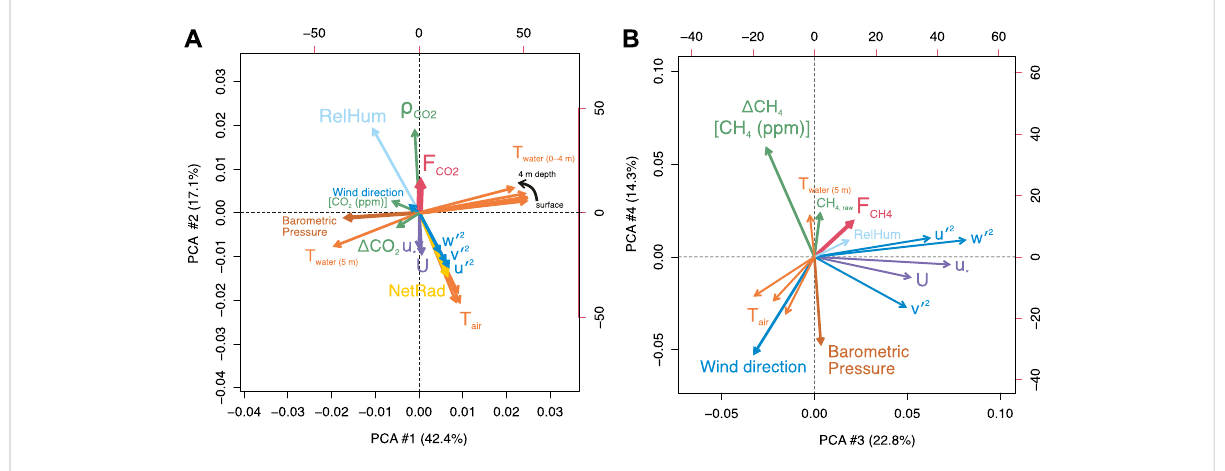
FIGURE 4 Principal component biplots of (A) CO 2 fl ux and (B) CH 4 fl ux with the most relevant potential driver variables. The CO 2 fl ux (F CO2 ) already appears prominently in PCA # 2, thus the fi rst two PCAs are displayed in (A) , whereas the CH 4 fl ux (F CH4 ) only appears in PCA # 3, hence the third and fourth PCAs are shown in (B) , and the percentage of explained variance is modi fi ed by excluding PCAs #1 and #2 from the total in (B) . U is the mean horizontal wind speed, and u * the friction velocity (downward-directed momentum fl ux); u ′ 2 , v ′ 2 , and w ′ 2 are the turbulent variances of horizontal along-wind, across wind, and vertical wind fl uctuations, respectively. ρ CO2 is the CO 2 density in air (mmol m − 3